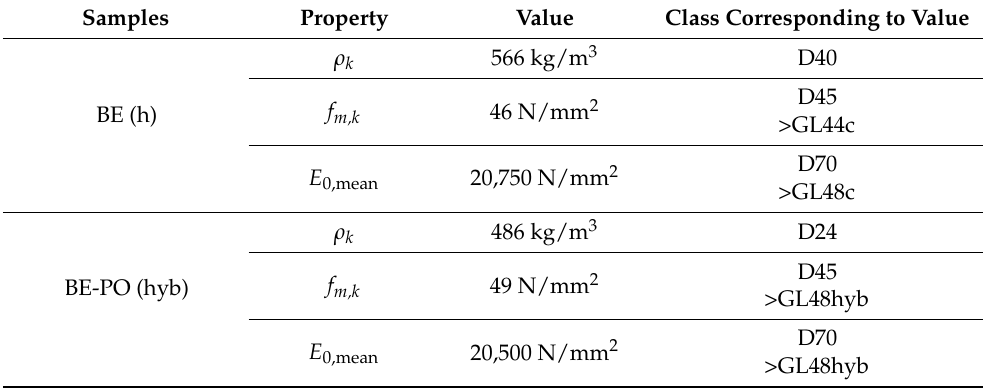
Table 10. Strength classes of the tested GLT beams. Estimation of the strength classes according to